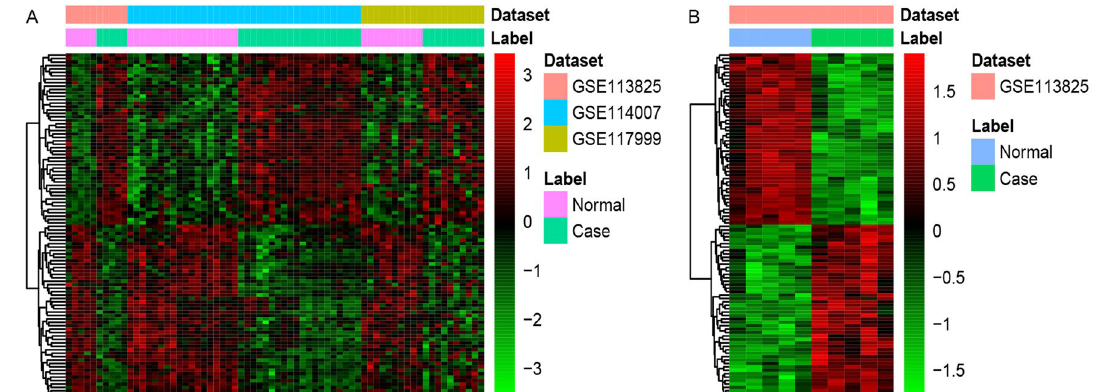
Fig. 1 The heatmap of top 100 up- and down-regulated DEmRNAs ( A ) and DElncRNAs ( B ) in OA